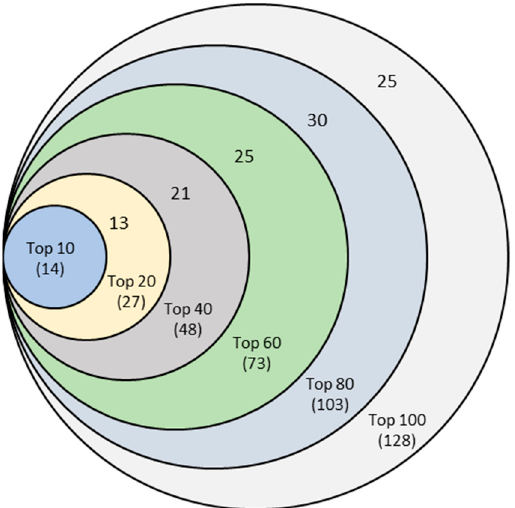
Figure 4. Venn diagram of six sets of unique features identified from six mrCAE systems. The mrCAE consisted of 10, 20, 40, 60, 80, and 100 runs. Each of these runs was conducted to select 100 features. The smallest set (light blue), containing 14 features, represents the unique features coming from six sets of 10 most frequent features from 10-, 20-, 40-, 60-, 80-, and 100-run mrCAE systems. Similarly and so on, the 2nd smallest set contains 27 (14 + 13) unique features from six sets of Top-20 features selected.